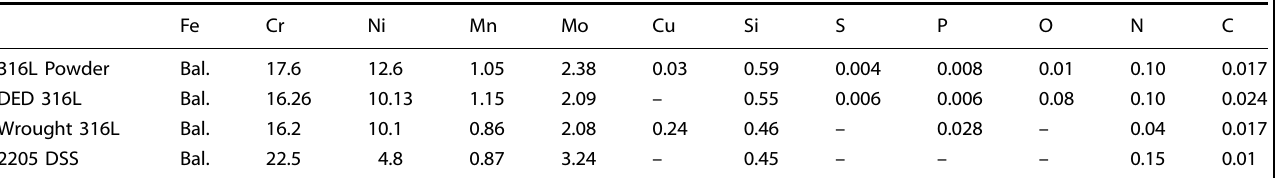
Table 2. The chemical compositions of metal powder and the studied materials (wt.